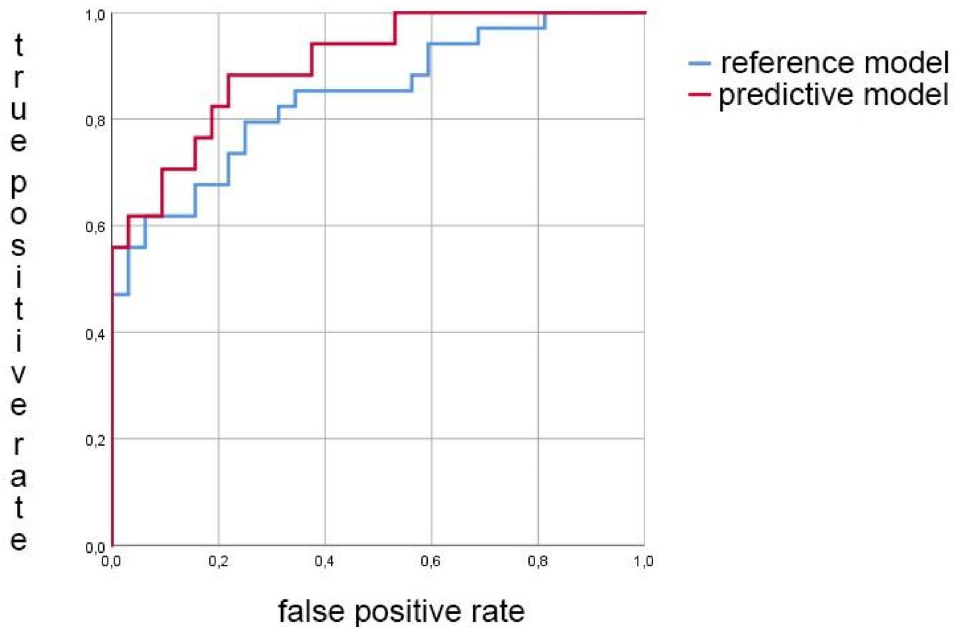
Figure 1. The receiver-operator curves (ROCs) for the predictive model (red) using selected AE signals, KI, age and BMI, and for the reference model (blue) using age and BMI in females. Significant statistical difference was found using DeLong method ( p <